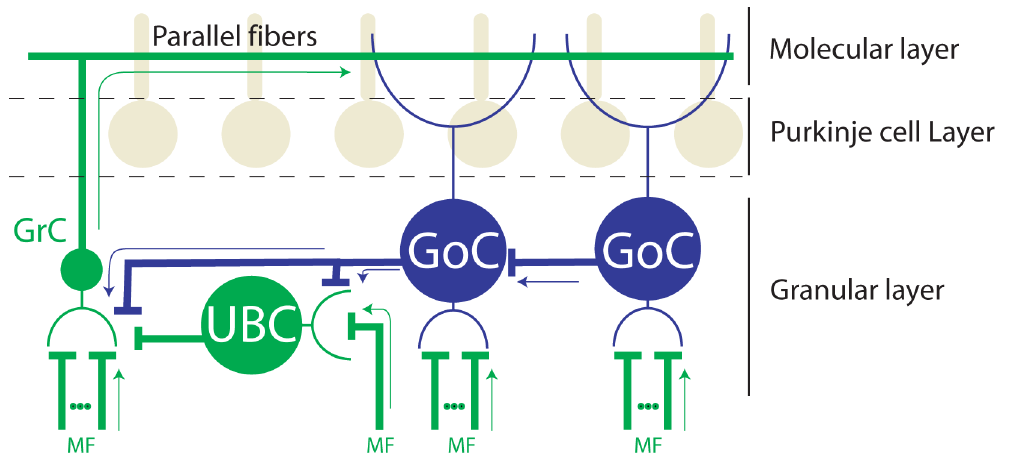
Figure 1. Schematic diagram illustrating direct and indirect pathways connecting mossy fibers (MF) to GLIs. Arrows indicate the directionality of the signal flow. Granule cells (GrC) receive glutamategic inputs from MFs and UBCs, and glycinergic/GABAergic inputs from Golgi cells (GoC). Unipolar Brush cells (UBC) receive a single mossy fiber input and glycinergic/GABAergic inputs from nearby Golgi cells. UBCs in turn establish glutamatergic synapses with granule cells and other UBCs. Golgi cells receive glutamatergic inputs from mossy fibers and parallel fibers, and glycinergic/GABAergic inputs from other Golgi cells. For simplicity we show only the classical major connections and interneurons of the granular layer. We also separate them between glutamatergic pathways (green) and glycinergic/GABAergic pathways (blue), although we acknowledge that other neurotransmitters, pathways, and interneurons exist. Axons and dendrites are represented by thick and thin traces respectively.